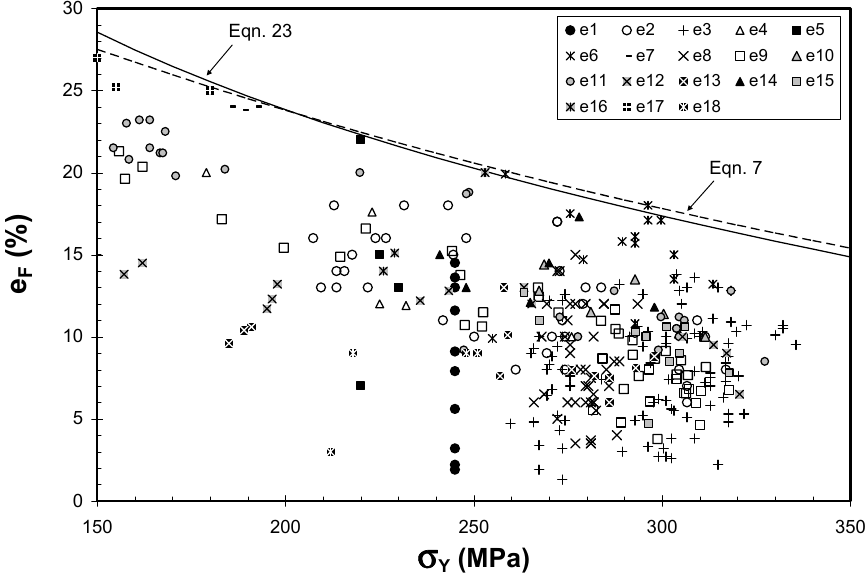
Figure 10. A survey of 18 published results for tensile elongation and yield strength of cast and heat treated Al – 7Si – 0.4Mg alloys from mainly aerospace foundries [33].